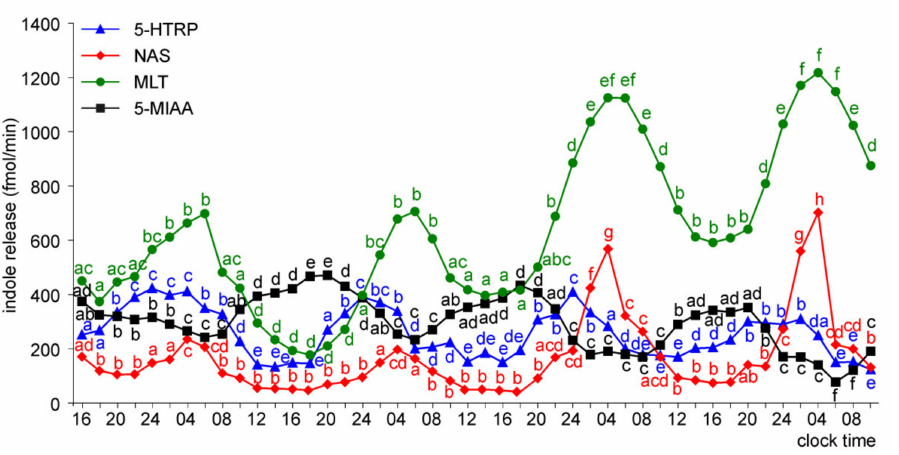
Figure 10. Release of 5-HTRP, NAS, MLT, and 5-MIAA (means, n = 3) from pineal organs of ED 28 embryos incubated under a 12L:12D cycle. The same letters indicate means, which are not significantly different between